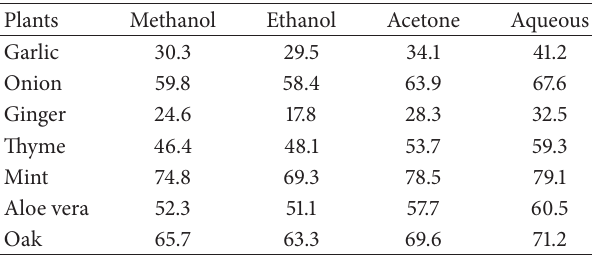
Figure 2: Total flavonoid Contents. Table 1: DPPH radical scavenging activity (IC 50 ) of extracts from different medicinal